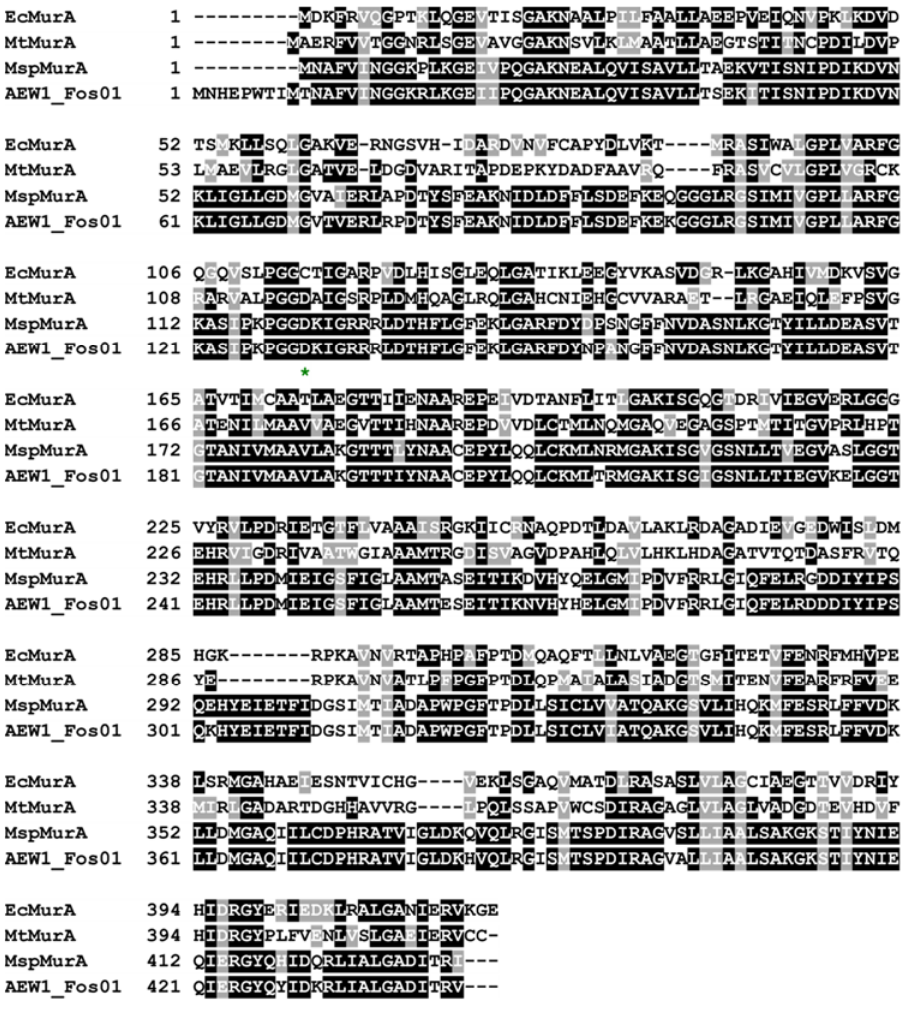
Figure 4. Amino acid alignment of AEW1_Fos01 and known MurA representatives. The active site Cys/Asp residue is indicated by a green star below the specific position. Besides AEW1_Fos01, the alignment includes Escherichia coli MurA (EcMurA, accession number: AAC76221), Mycobacterium tuberculosis H37Rv MurA (MtMurA, accession number: CAA65472) and a Mucilaginibacter sp. MurA (MspMurA, accession number: